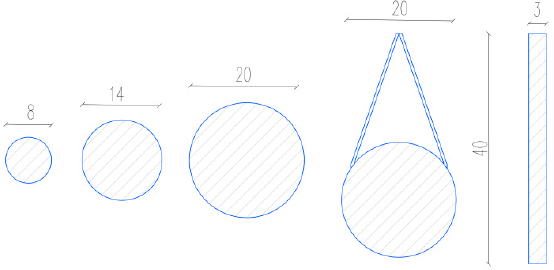
Figure 7. Types of test tips, left: Rod 8; rod 14; rod 20; drop; strips.